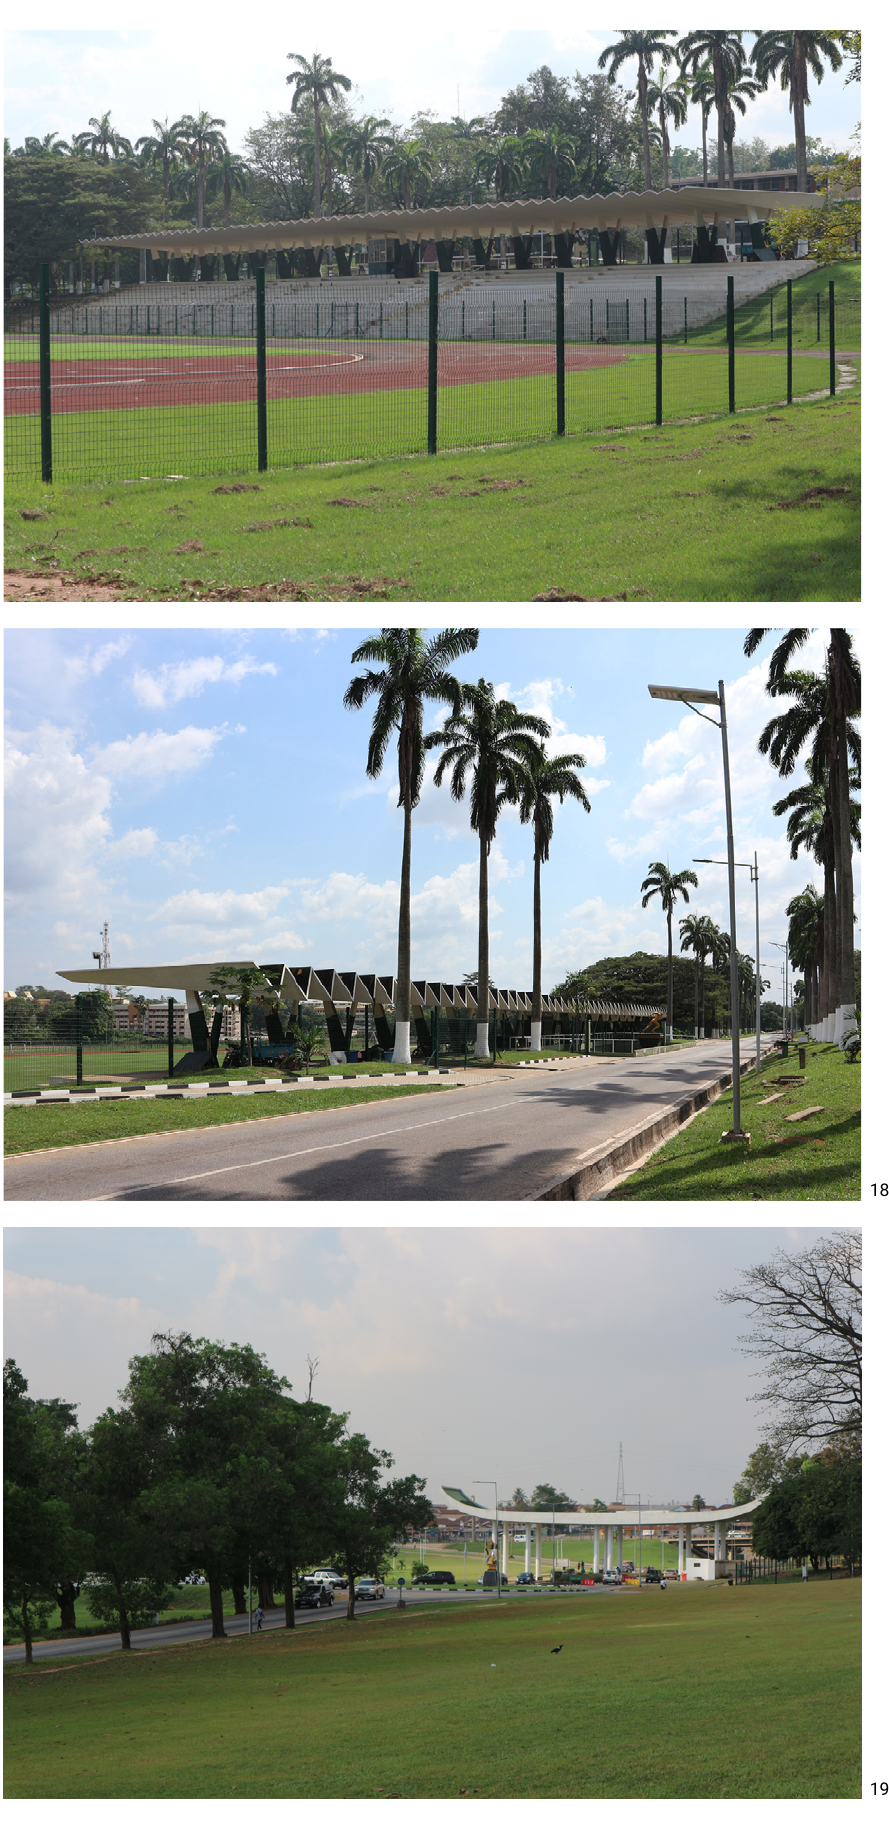
Berislav Kalogjera, KNUST University Entrance (Source: